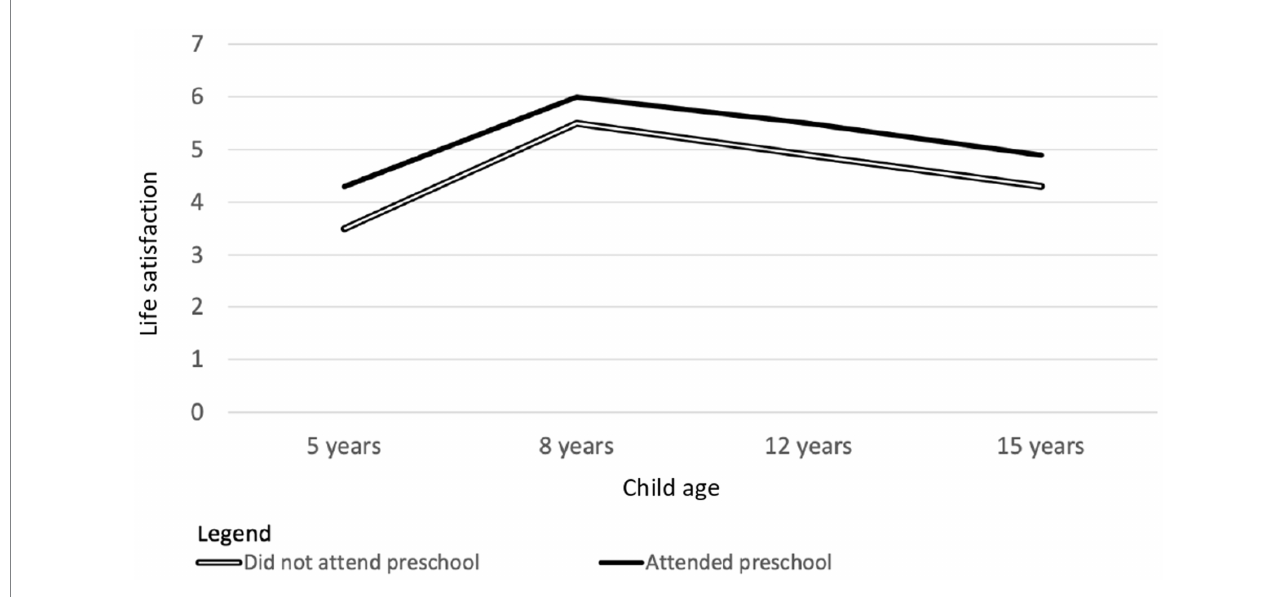
FIGURE 2 Ratings of life satisfaction at 5, 8, 12, and 15 years of age by children who did ( n = 1,562) and did not attend preschool ( n = 163).